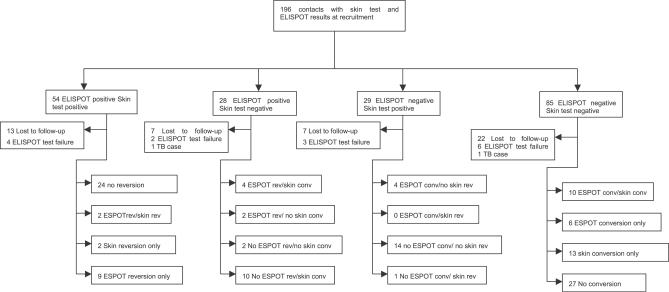
Study Profile: Recruitment and 18-Mo ELISPOT and TST Conversion and Reversion